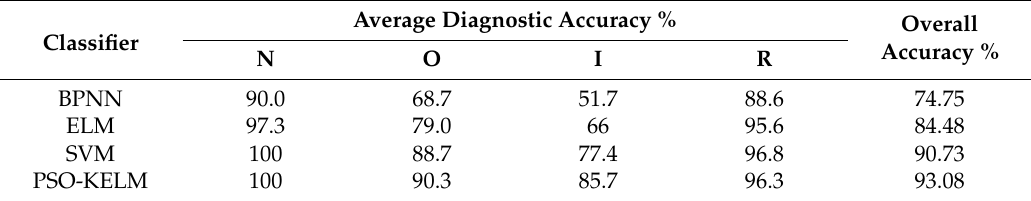
Table 5. Comparison results of different